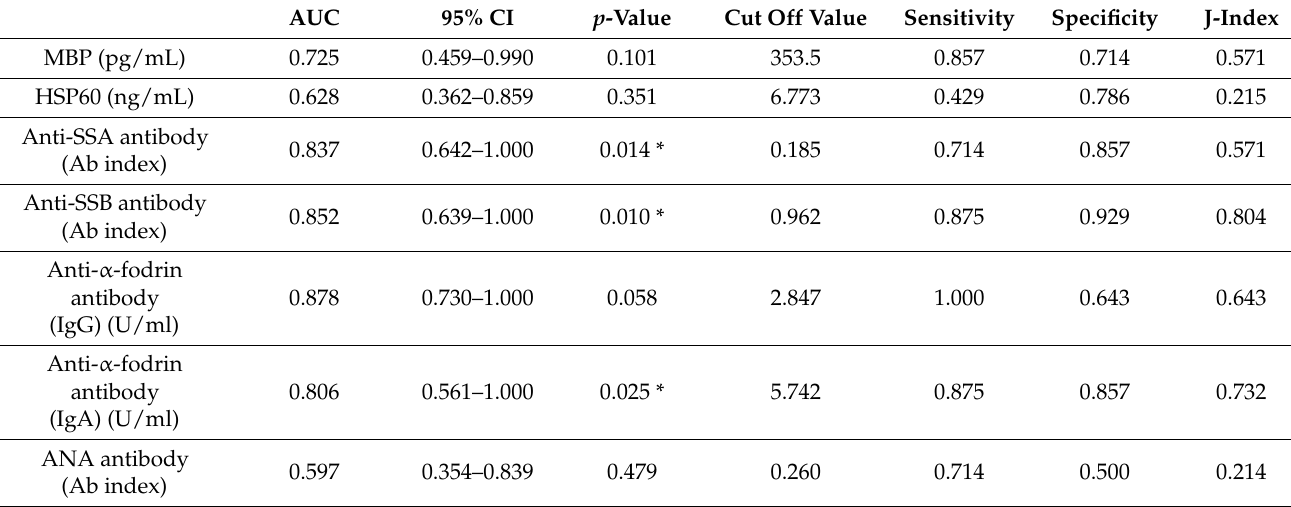
Table 3. Receiver operating characteristics curve analysis for discrimination between NTG and HTG.